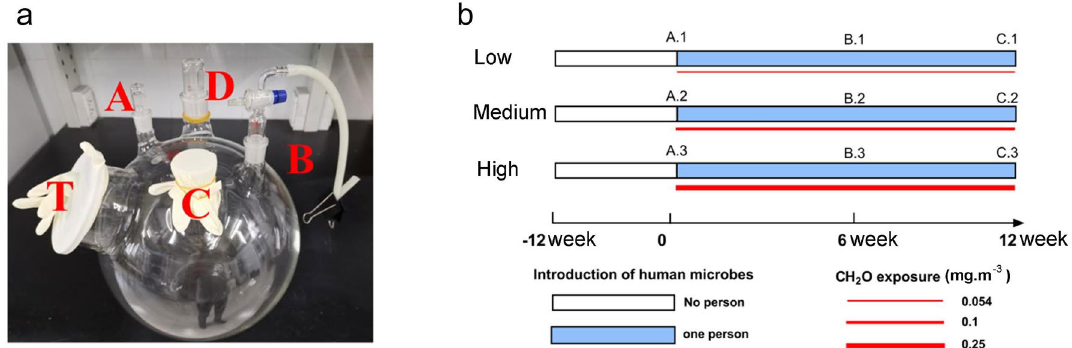
Figure 1. Containers used for simulation of the indoor environment ( a ). Sterile clean 90-mm dishes (without agar) were placed inside each container through the hole T. Hole A for CH 2 O injection, hole B for human input,